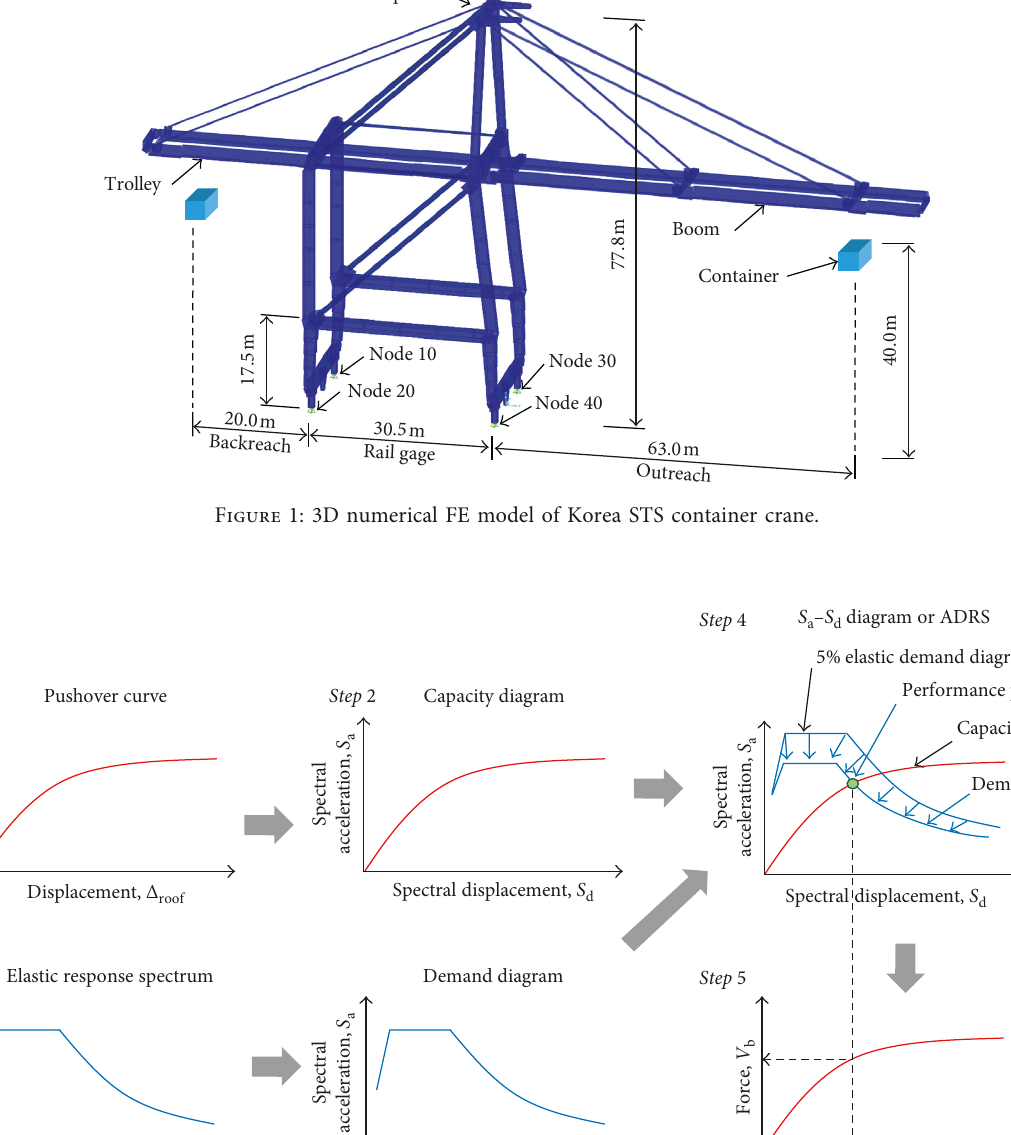
Figure 2: Conventional CSM